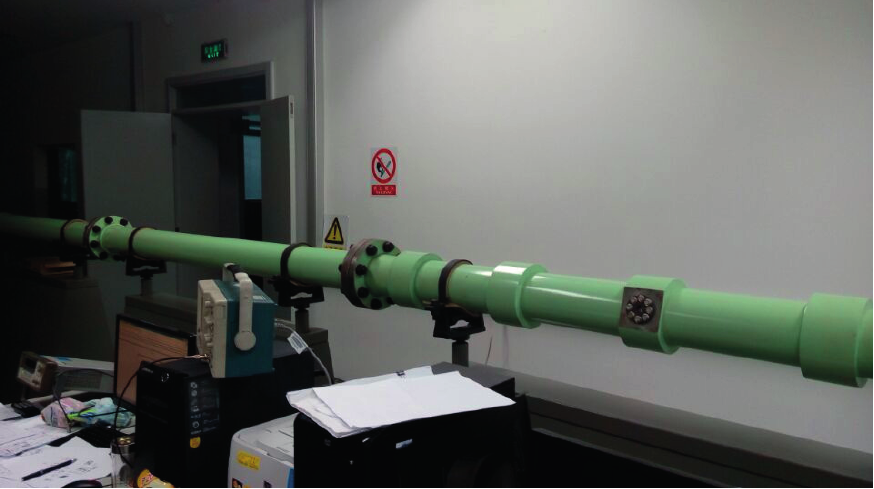
Figure 4. Shock tube calibration